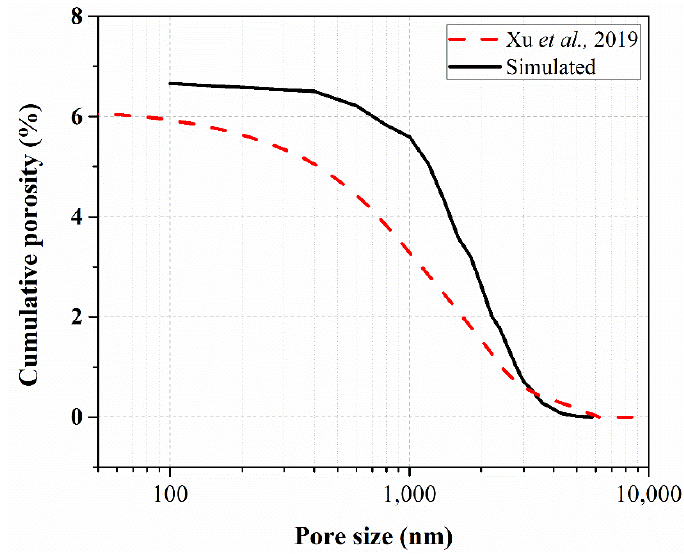
Figure 8. Porosity of simulated and experimental data in Ref. [15] for MP8H0.25K.